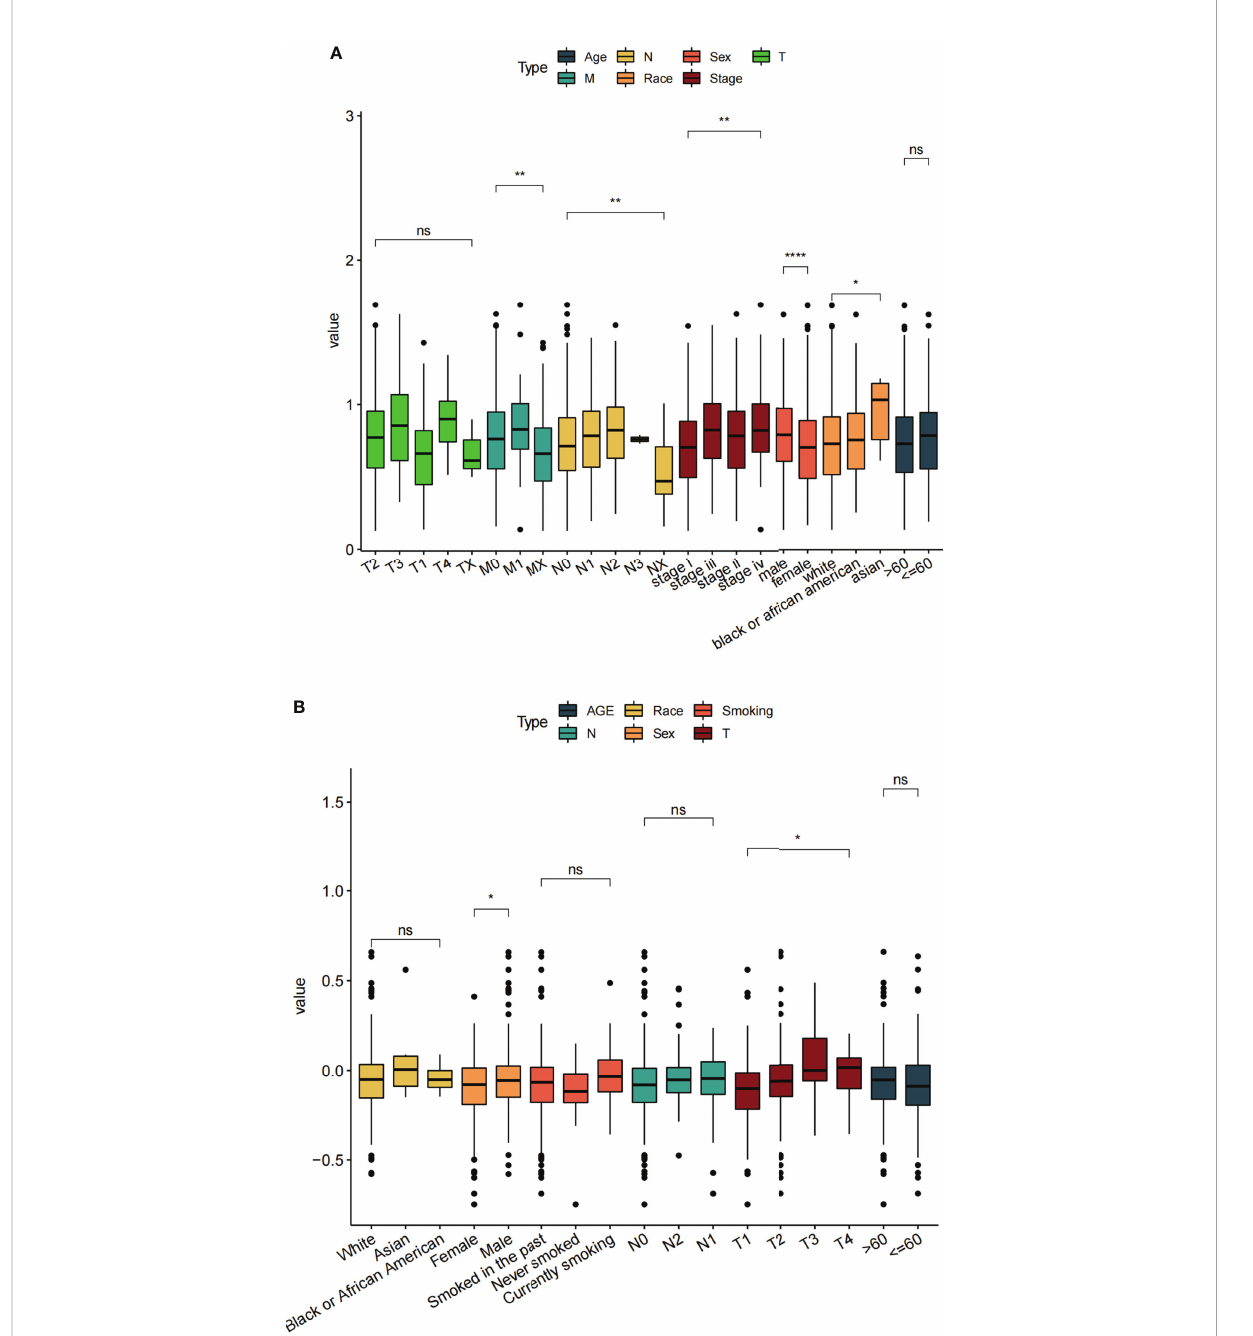
FIGURE 8 Correlation between different clinical features and risk score. (A) TCGA datasets. (B) GSE68465 datasets. ns: p > 0.05, * p < 0.05, ** p < 0.01, **** p <